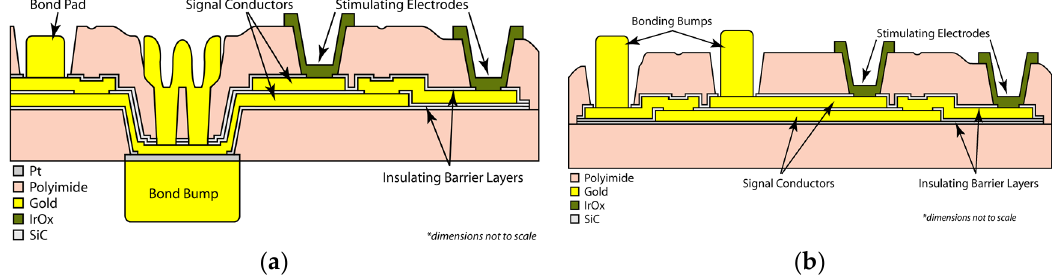
Figure 5. Two process flows for microfabrication of flexible, implantable planar multi-electrode arrays for use in retinal prostheses. ( a ) A double-sided process, in which the contact pads may be located on either or both sides of the array; ( b ) A single-sided process, in which the contact pads for bonding to the stimulator package are on the same side of the array as the iridium oxide stimulating electrodes themselves (see also Table 3).